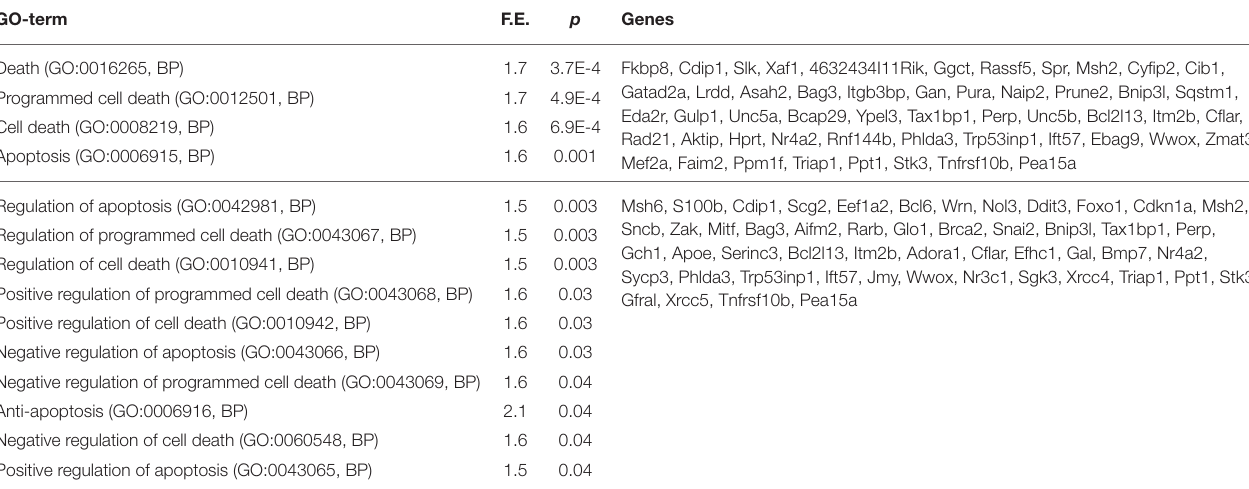
TABLE 6 | GO-terms related to cell death or apoptosis that were significantly down-regulated during maturation of the SCG neurons.